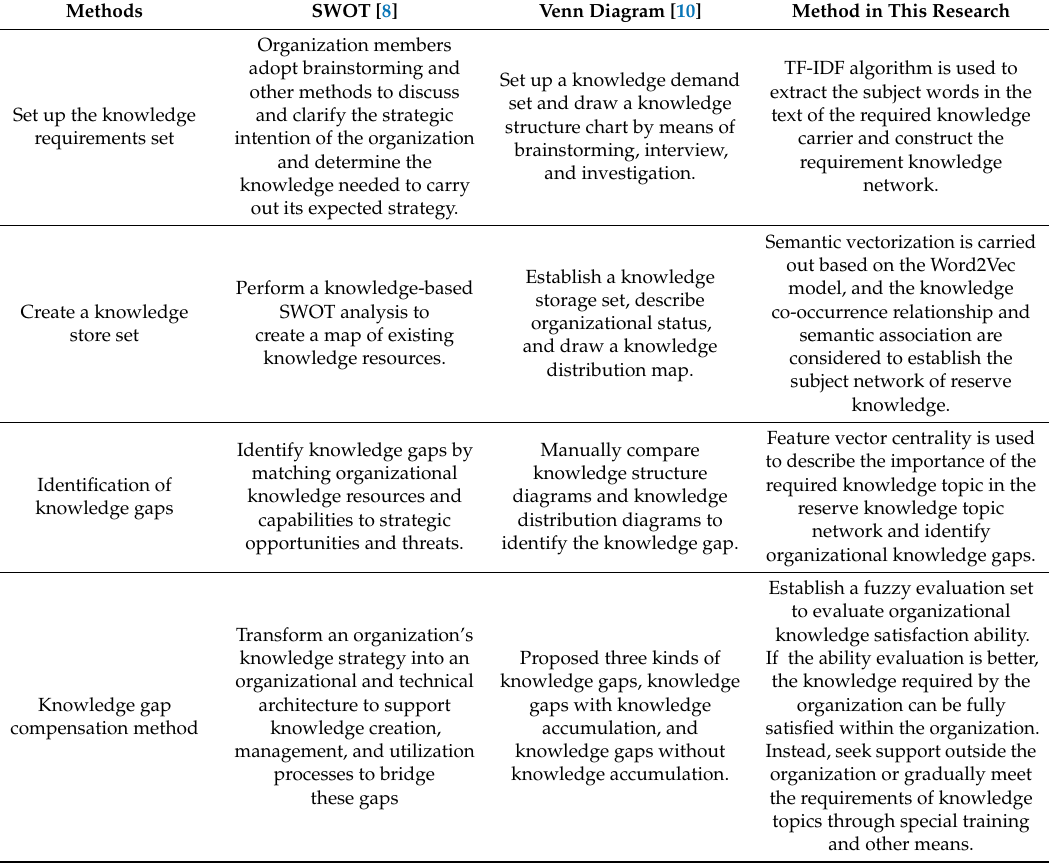
Table 2. The comparison of SWOT, Venn diagram and the Method in this research on knowledge gap identification and